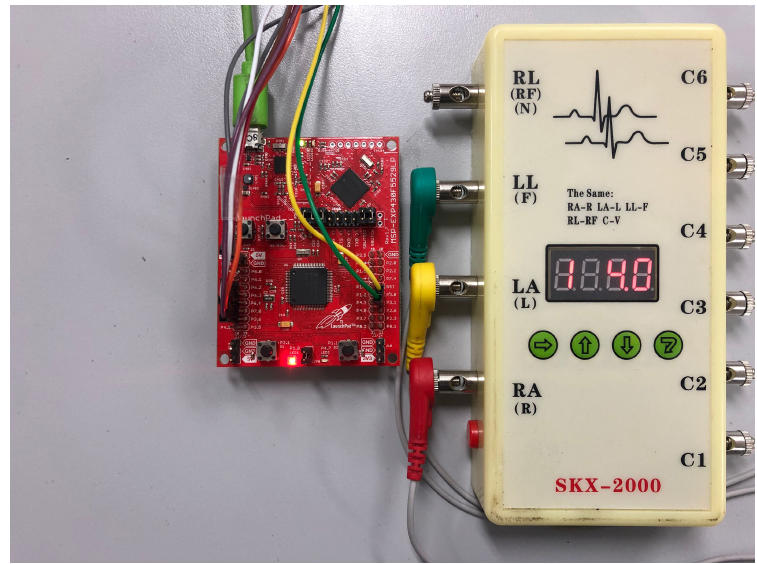
Figure 10. The output heart rate of the ECG simulator is 80 BPM, which simulates the normal condition of the heart rate, and the system does not set off an alarm.